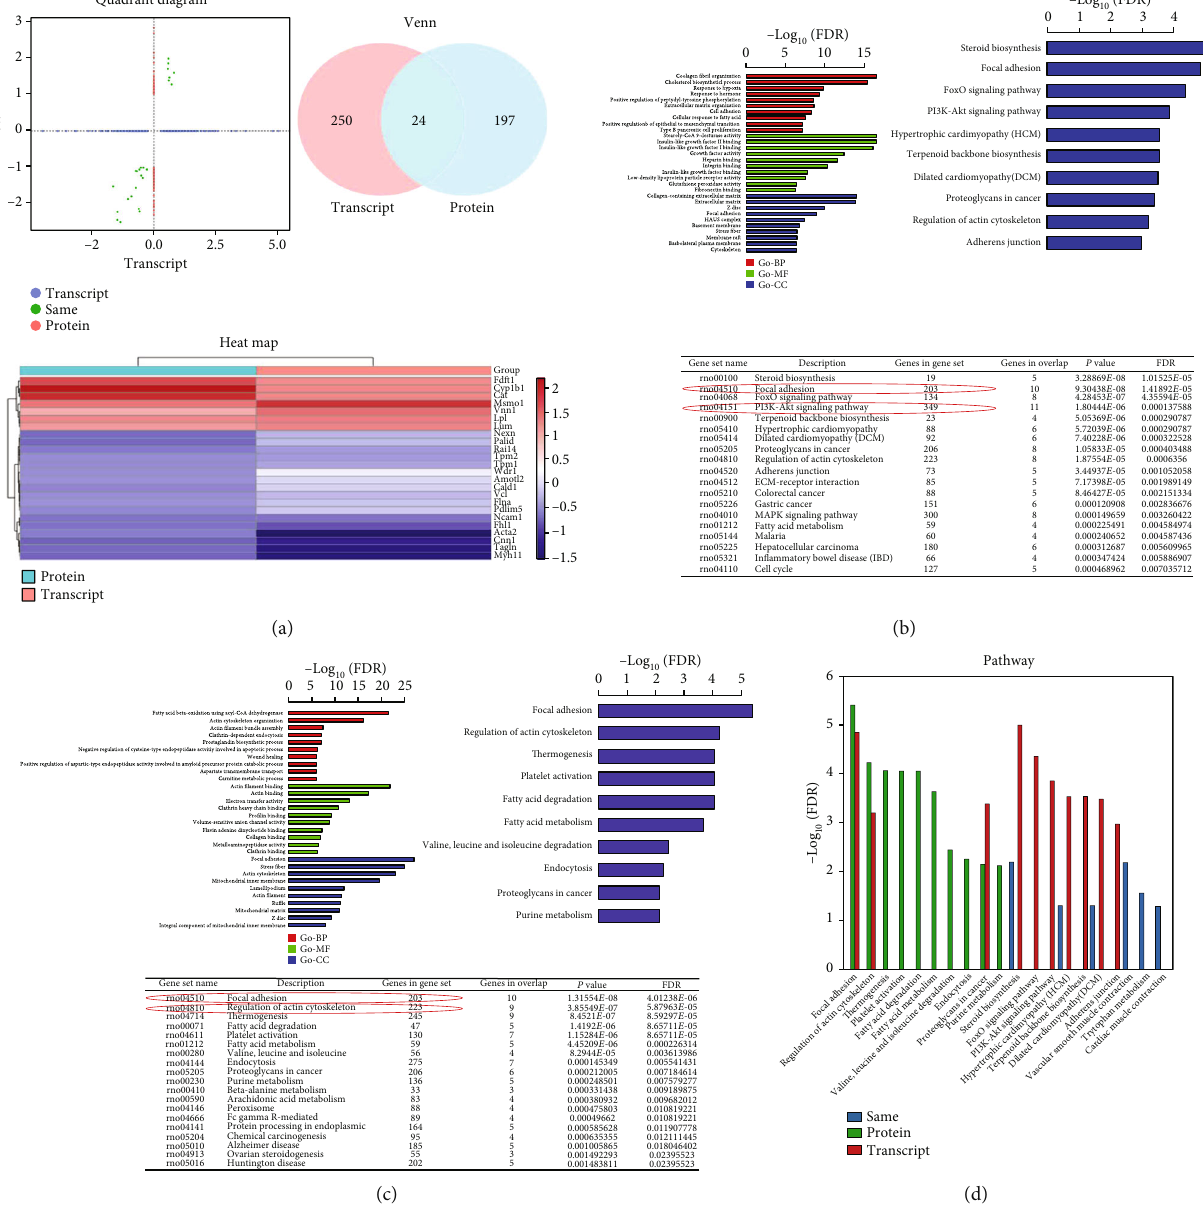
Figure 4: Results of bioinformatics analysis. (a) The quadrant diagram, Venn diagram (Venn), and heatmap of combined analysis of transcriptomics and proteomics. (b) The transcriptome sequencing results, including GO and KEGG enrichment analyses. (c) The proteomic results, including GO and KEGG enrichment analyses. (d) Signaling pathway enrichment analysis of combined transcriptomic and proteomic sequencing